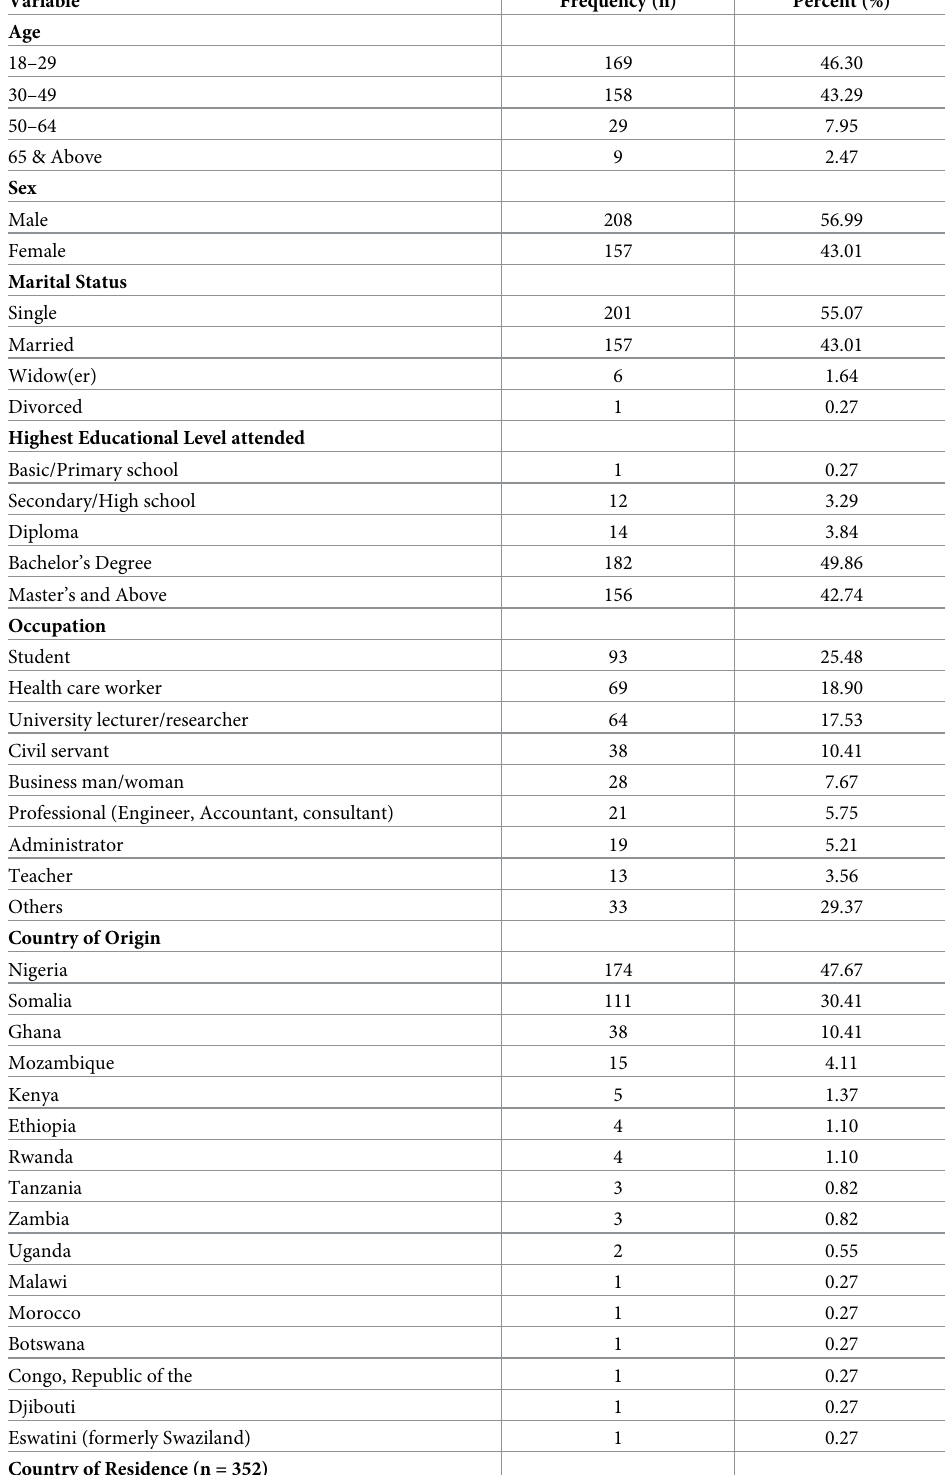
Table 1. Demographic information of respondents (n =